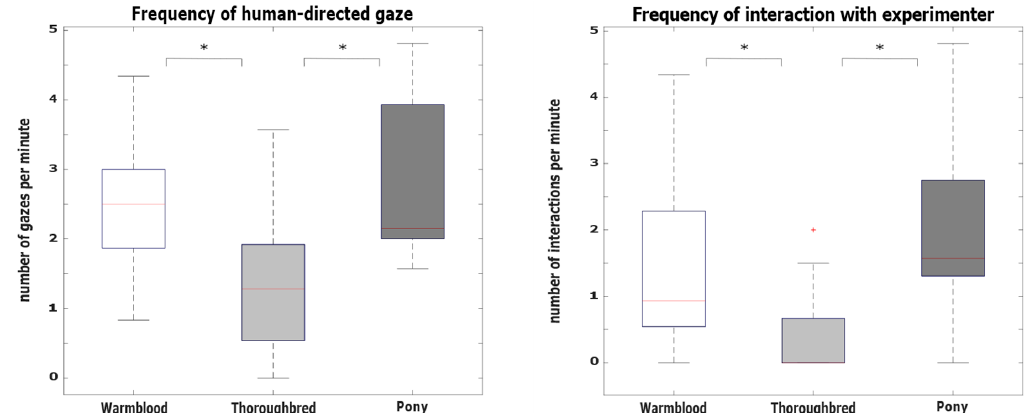
Figure 3. Behavioral di ff erences between breeds. ( a ) Di ff erences in frequency of human-directed gaze between breeds ( H (2) = 12.00, p = 0.002, d = 1.10). Thoroughbreds displayed fewer gazes towards humans compared to ponies and warmbloods. ( b ) Di ff erences in frequency of physical interactions with human between breeds ( H (2) = 13.07, p < 0.001, d = 1.18). Thoroughbreds interacted less frequently with human compared to ponies and warmbloods.